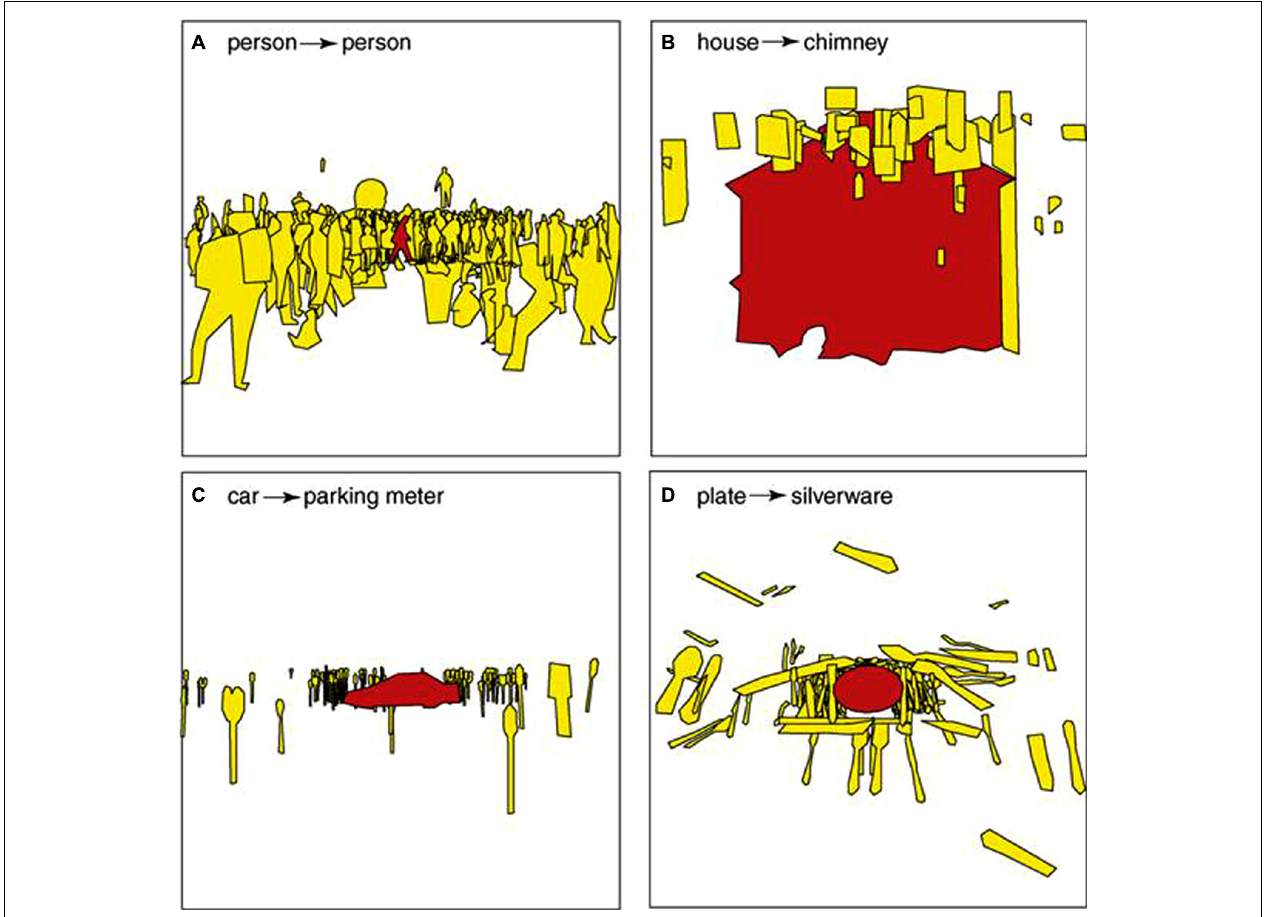
FIGURE 5 | Illustration of spatial dependency among objects. Without being directly fixated, the identities and locations of target objects (shown in yellow) are conditional to the recognition of a reference object (shown in